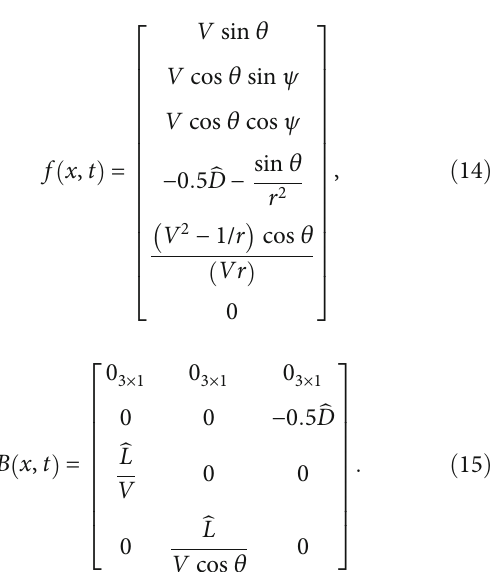
Table 3: Terminal